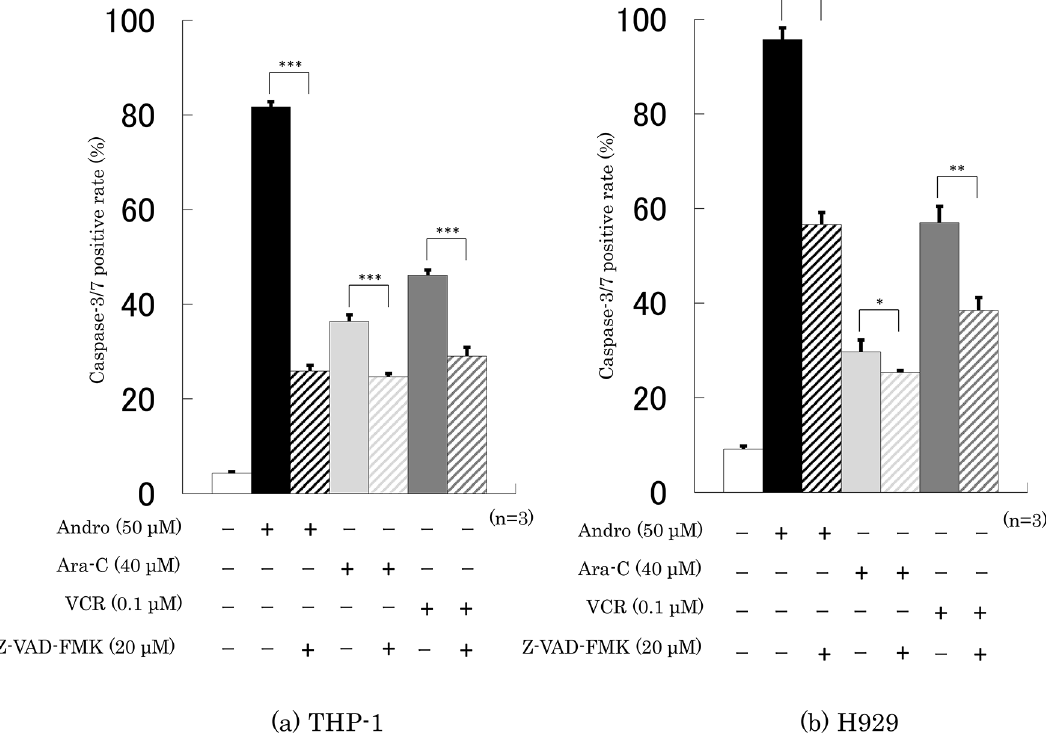
Figure 5. Treatment for 24 h with Andro, Ara-C, or VCR enhanced the caspase-3/7 activities in THP-1 (a) and H929 (b) cells, and the level of enhancement was reduced in the presence of the pan-caspase inhibitor Z-VAD- FMK. The results are expressed as mean (cid:4) SD of three independent experiments (*P < 0.05, **P < 0.01, ***P < 0.001, comparing with and without